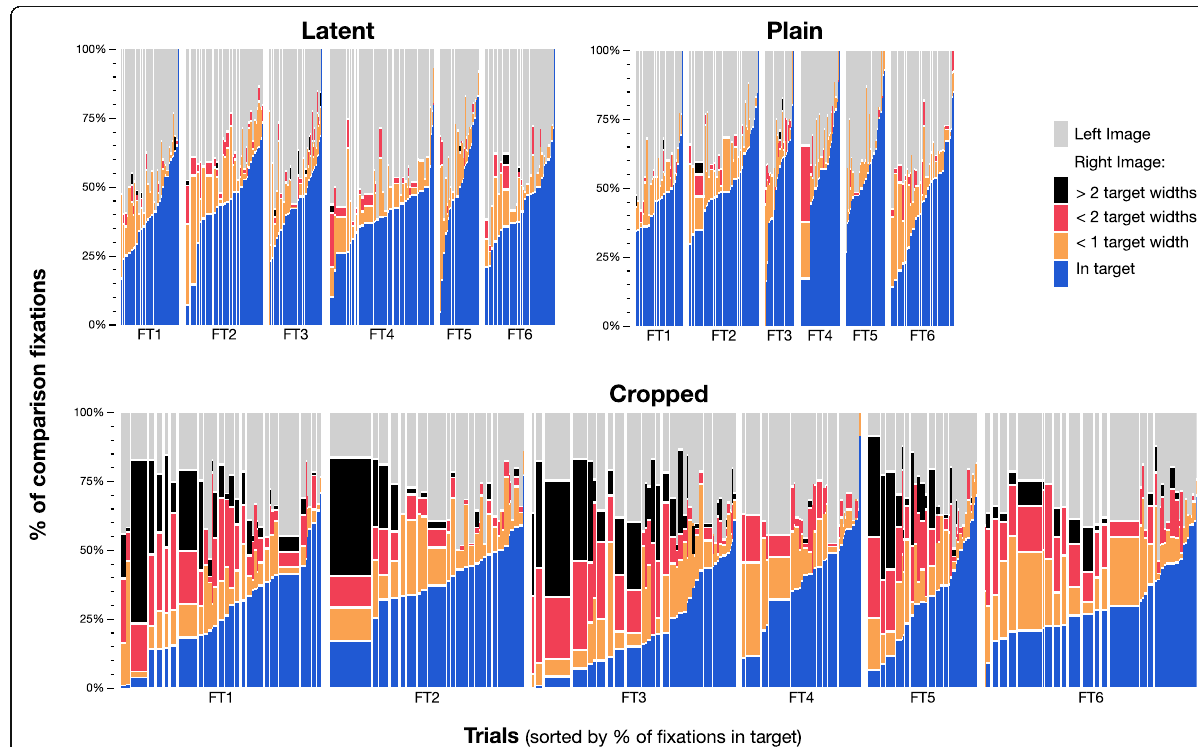
Fig. 5 Distance of fixations from target, by task type, image set, and trial. These mosaic plots describe for each trial the proportion of comparison fixations on the left and right images, and by distance from target in right image, for each task type. Each column is one trial, sorted by the percentage of fixations in the target on the right image; column width is proportional to number of fixations in that trial. ( n = 8956 fixations (Latent), 6171 (Plain), 20,116